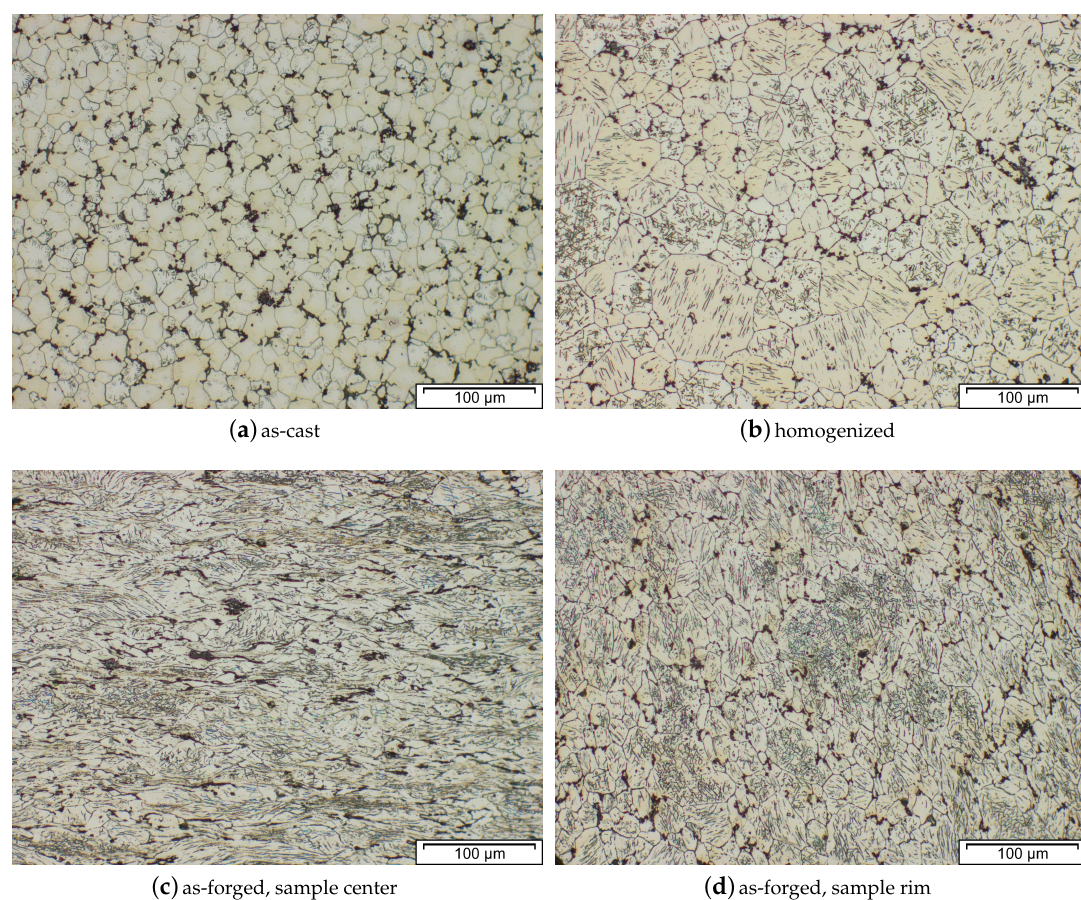
Figure 26. Microstructure of WE43 in ( a )as-cast state as well as ( b )homogenized at 525 ◦ C for 24h. The material was forged at temperatures of 380 ◦ C and 280 ◦ C for material and die respectively using a ram speed of 10mms − 1 . The as-forged, air-cooled microstructures of ( c )sample center and ( d )sample rim are depicted as